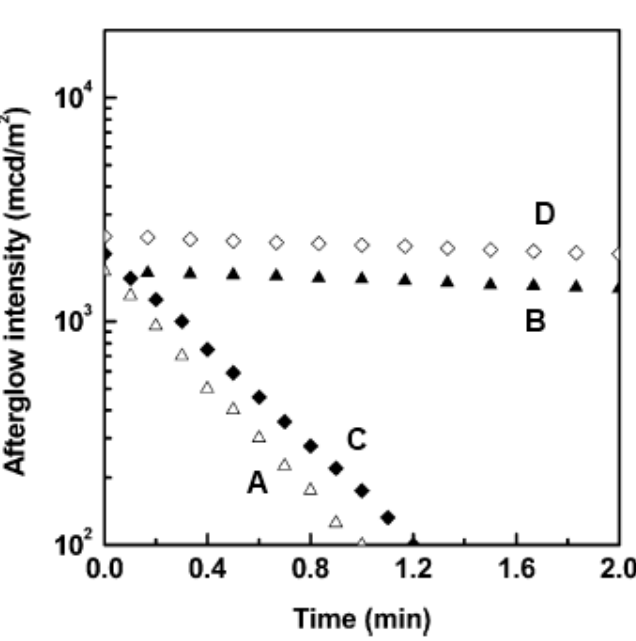
Figure 4. Afterglow decay curves for A: SrAl B O , C: Sr 2 3 permission from